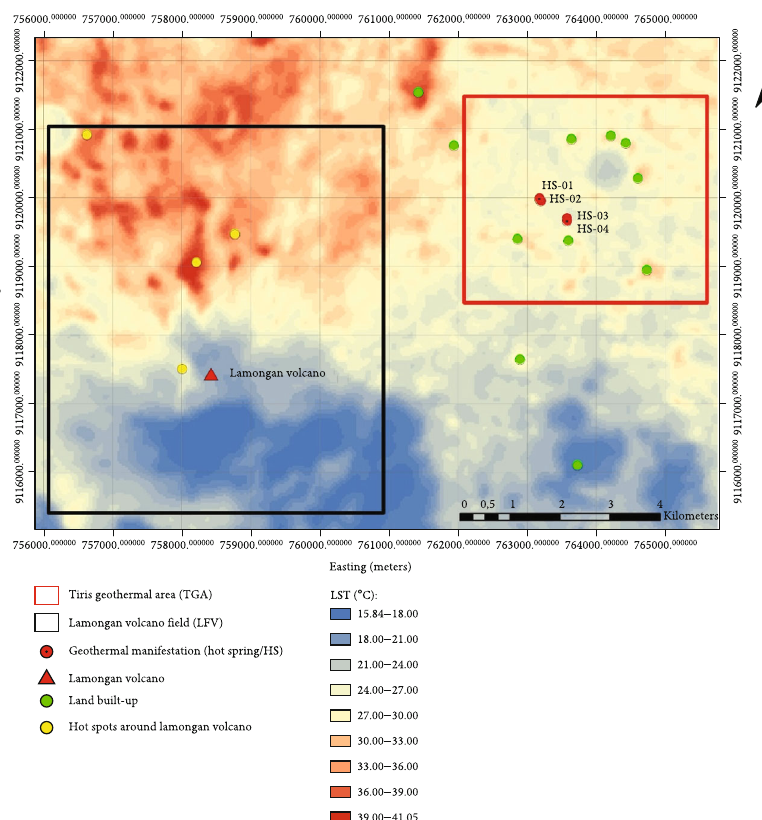
Figure 5: Estimation of ESG results from satellite coverage for the Tiris geothermal area of the Lamongan Volcano complex.